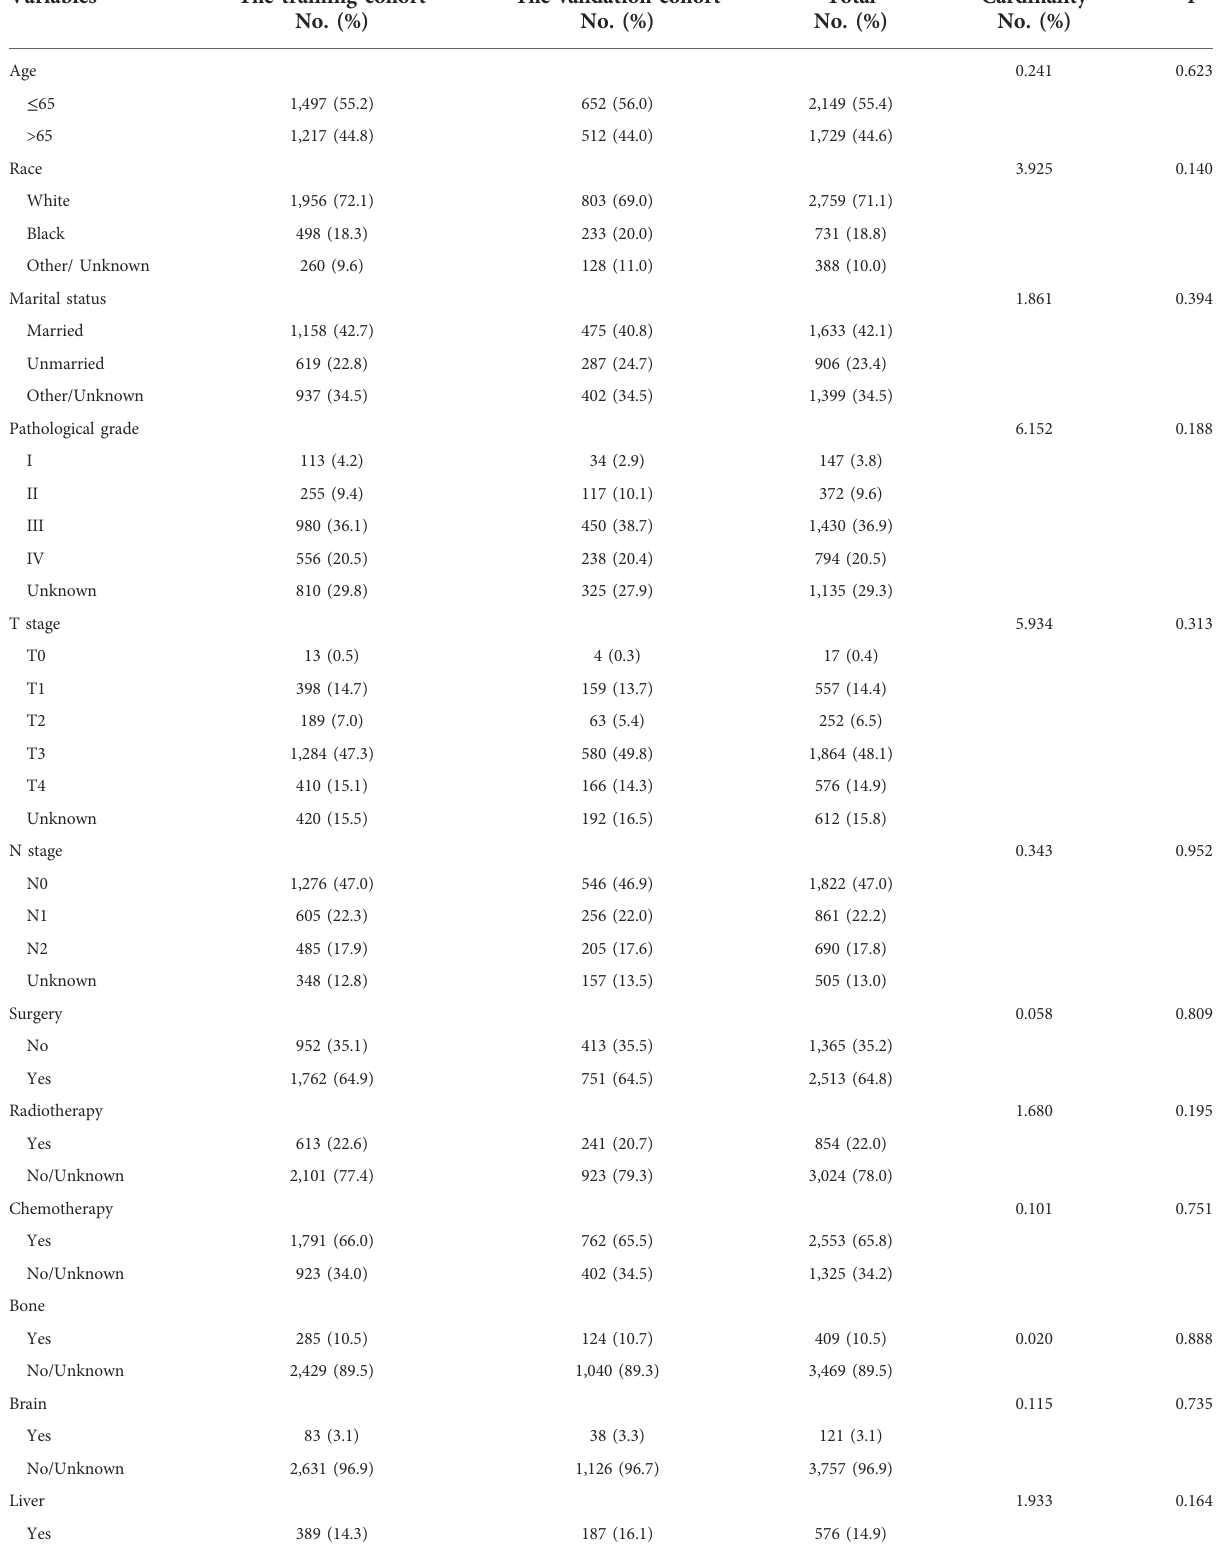
TABLE 1 Distribution of basic clinical features of patients with metastatic endometrial